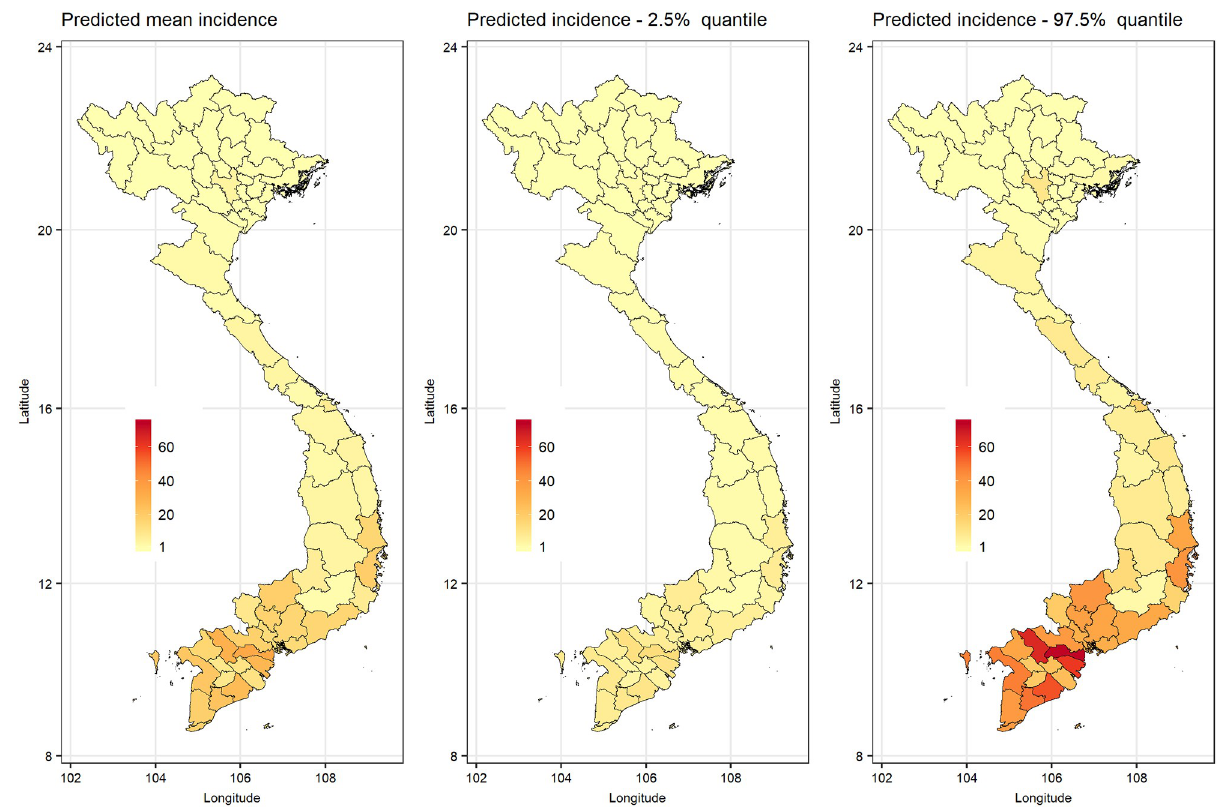
Fig 8. Predicted dengue mean incidence for 2010–2012, with 2.5% and 95% quantiles.